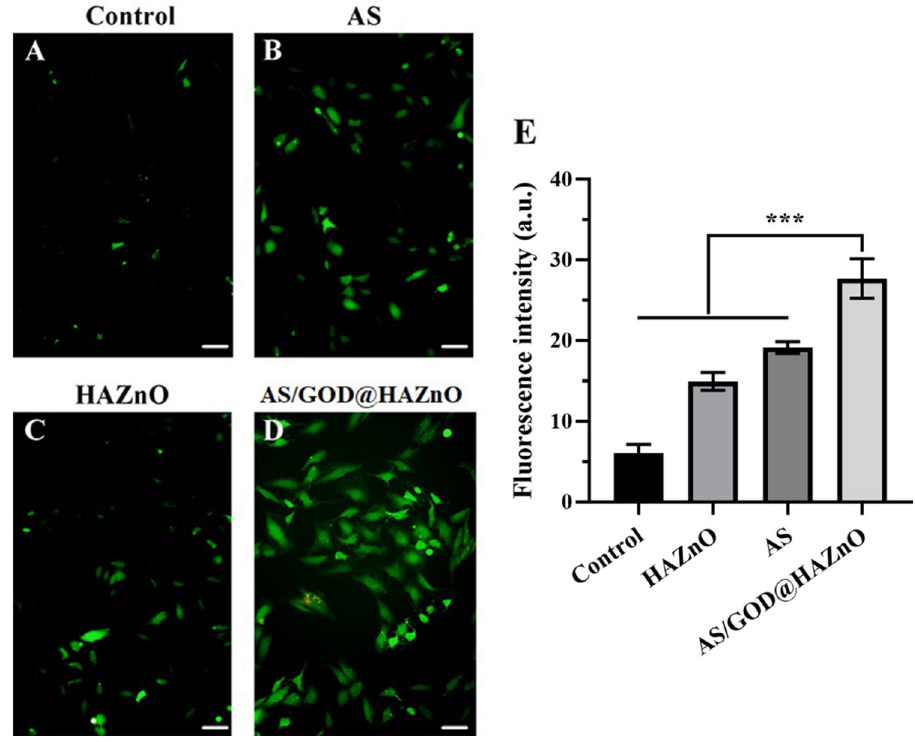
Figure 5. Fluorescence images indicate the intracellular ROS level of Control ( A ), AS ( B ), HAZnO ( C ), and AS/GOD@HAZnO ( D ) group; Scale bar = 100 μm. ( E ) The semiquantitative analysis of fluorescence images of ROS level. Data are presented as mean ± SD, n =